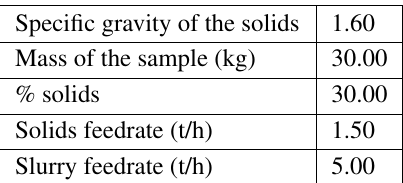
Table 2. Rougherspiral test conditions